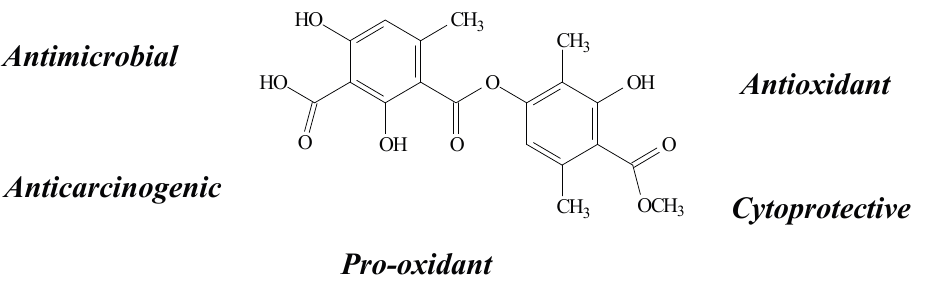
Figure 3. Atranorin structure and biological